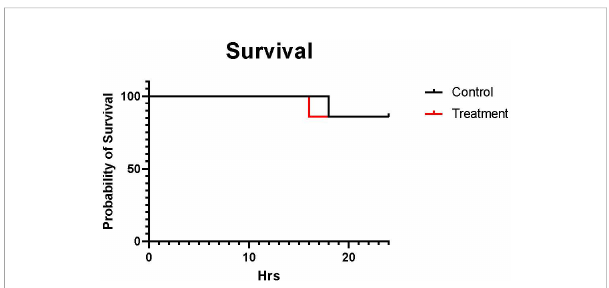
FIGURE 1 The Kaplan-Meier curve of the mortality rate. The black line shows control (n=7 at 0-18 h and 6 at 19-24 h), and the red line shows treatment (n=7 at 0-16 h and 6 at 17-24 h). The mortality rate was calculated by dividing the number of sheep that not survived within 24 h by the total number of sheep in each group. The mortality rate was similar between males and females (14% vs.